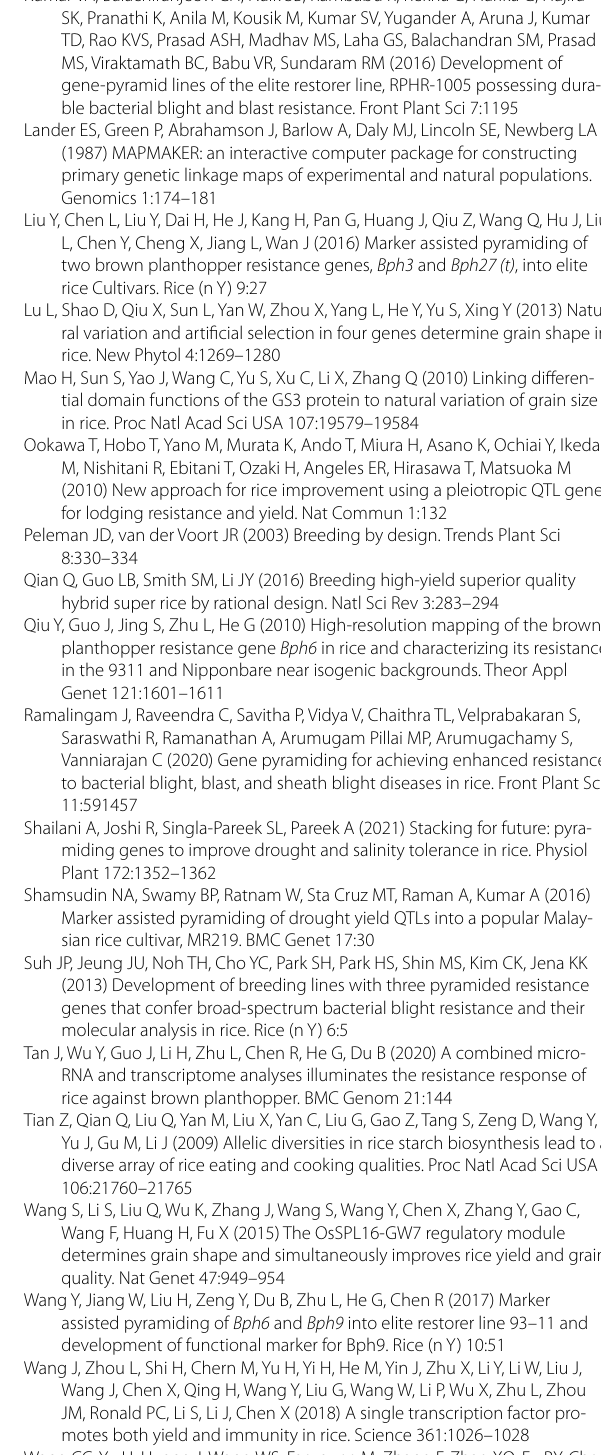
Additional file 2: Table S1 Agronomic trait performance of the parents in designed breeding; Table S2 The grain quality characters of the parents in designed breeding; Table S3 Target genes and related markers used in this study; Table S4 Agronomic trait performance of the BC 3 F 4 lines and their parents; Table S5 The grain quality characters of the BC 3 F 4 lines and their parents; Table S6 Agronomic trait performance of the parents and 18 elite lines. Lines 07, 08 and 14 were subsequently selected and renamed MD1, MD2 and MD3, respectively. (Target genes for Lines 01 to 18 in Fig. S6.); Table S7 The grain quality characters of the parents and 18 elite lines. Lines 07, 08 and 14 were subsequently selected and renamed MD1, MD2 and MD3, respectively. (Target genes for Lines 01 to 18 in Fig. S6.); Table S8 258 SSR markers used in this study; Table S9 Genetic back- ground screening information of the design breeding